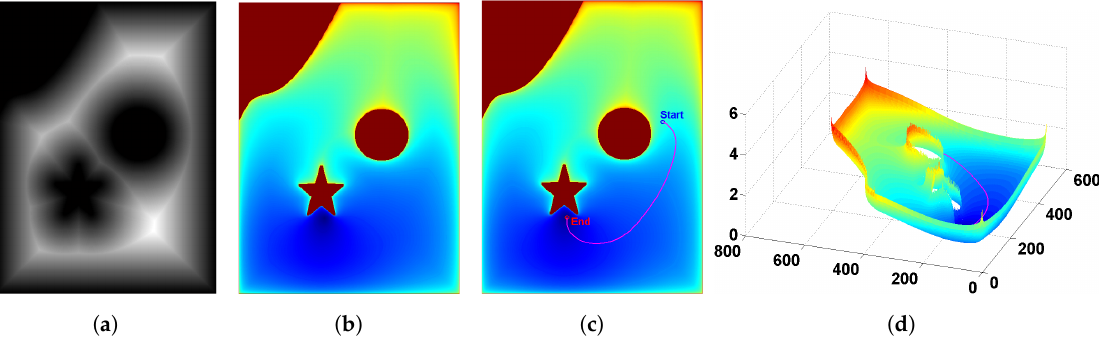
Figure 6. Path planning with the fast marching square (FMS) method. ( a ) The safety potential map V ; ( b ) The arrival time matrix T ; ( c ) Path obtained after applying gradient descent on T ; ( d ) Generated path and arrival time matrix T in three dimensions.